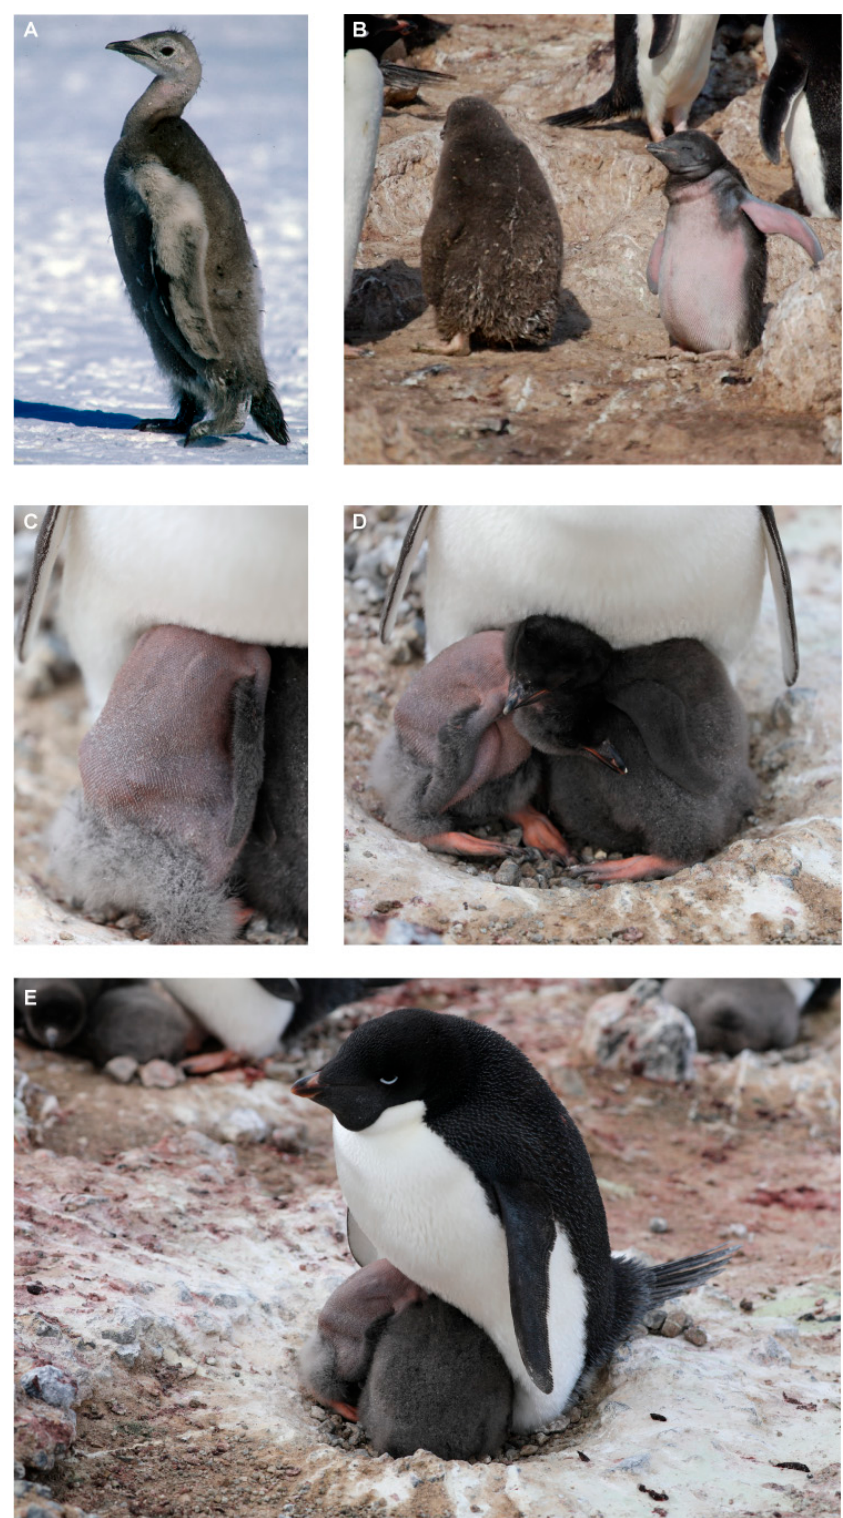
Figure 1. ( A ) Emperor penguin chick with feather-loss disorder (1996) at Cape Washington, northern Victoria Land, and in southern Victoria Land, Ross Island; ( B ) Adélie penguin chick with feather-loss disorder at Cape Royds, southern Victoria Land (2011–2012 breeding season); ( C ) Adélie penguin chick with feather-loss disorder at Cape Crozier (2018–2019 breeding season); ( D ) Adélie penguin chick affected by feather-loss disorder (2018–2019 breeding season) on a nest at Cape Crozier with fully feathered sibling; and ( E ) an asymptomatic parent.